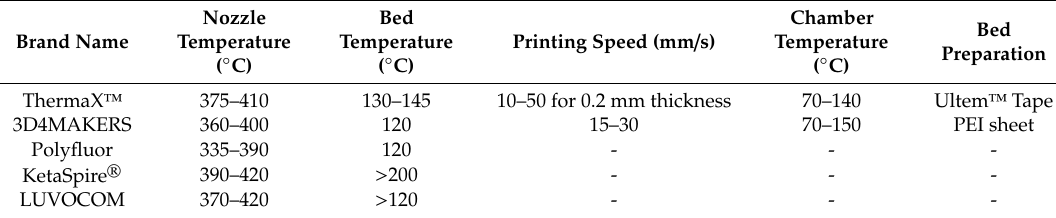
Table 3. Parameters of 3D printing of PEEK recommended by filament